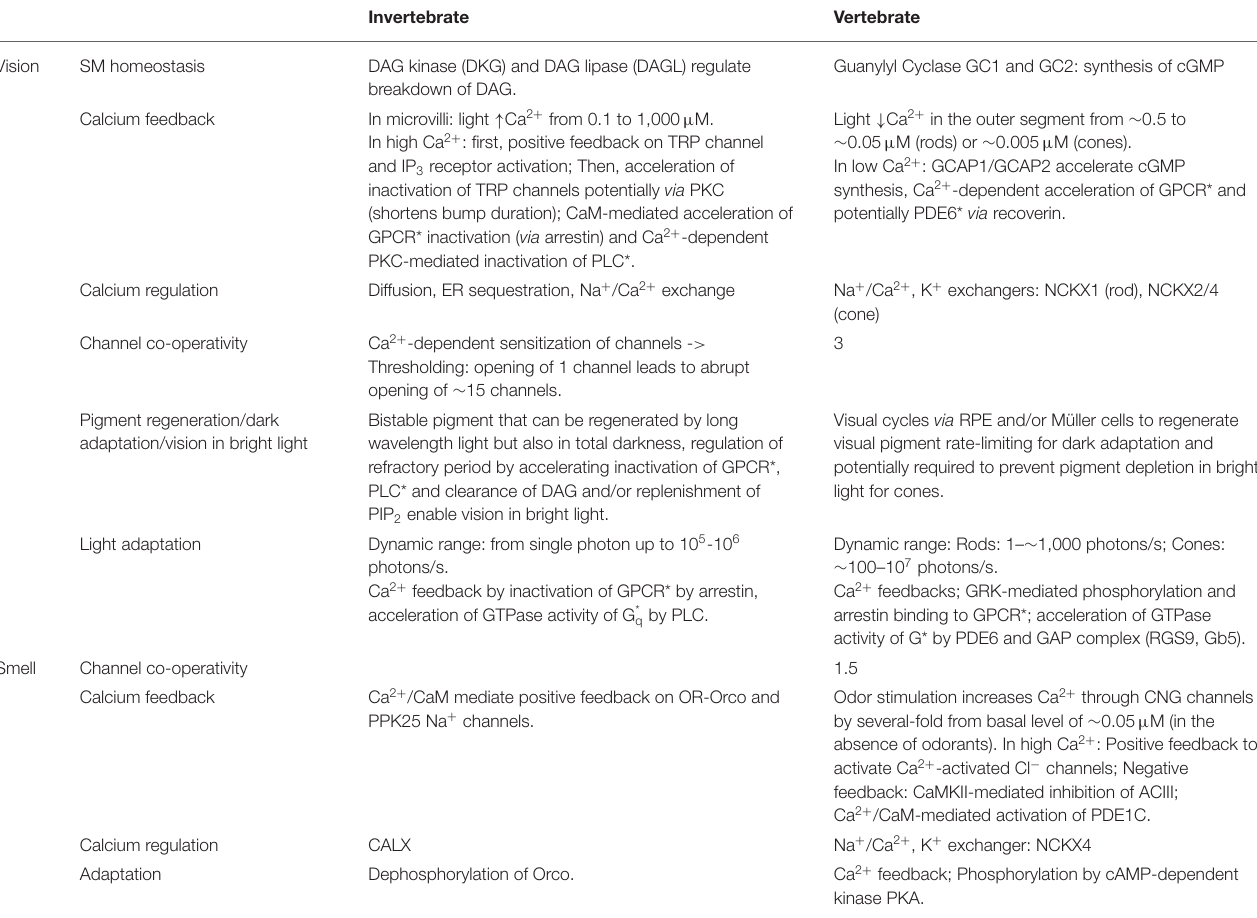
TABLE 2 | Overview and comparison of the adaptation and feedback mechanisms in invertebrate and vertebrate phototransduction and olfactory transduction